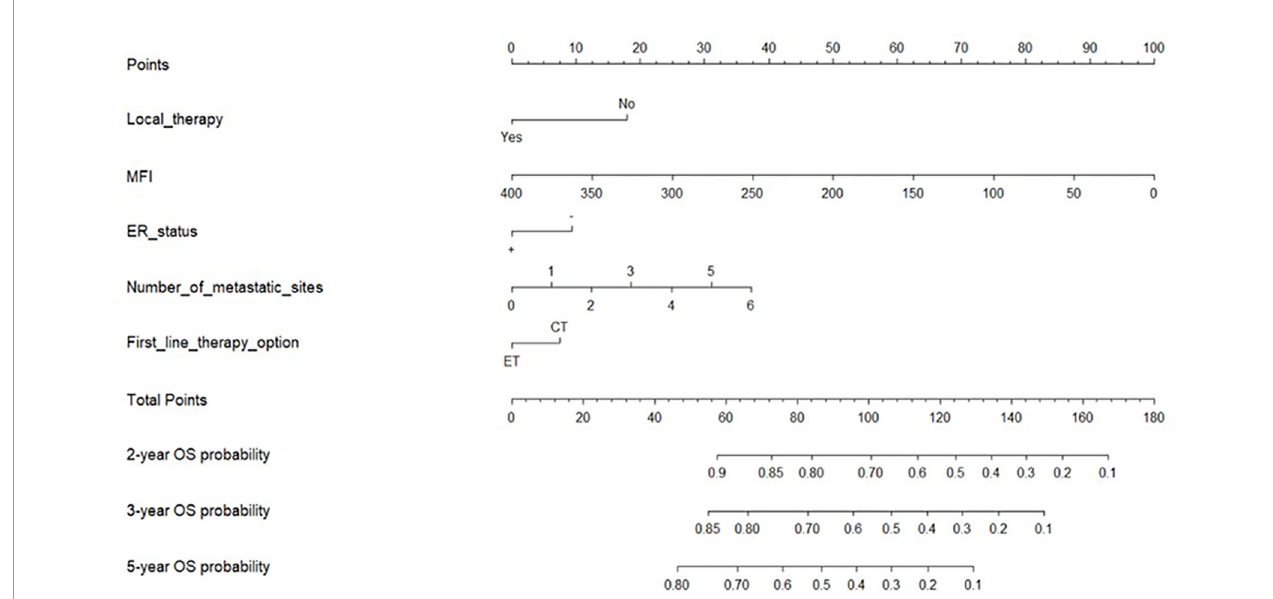
FIGURE 1 | Nomogram for predicting the 2-year, 3-year, and 5-year overall survival. Notes: Nomogram used when summing the points identi fi ed at top scale for each of the fi ve independent variables. This summed point score identi fi ed on total point scale was used to determinate 2-, 3- and 5-year overall survival (OS) probability of advanced breast cancer patients (ABC). MFI, metastatic-free interval; OS, overall survival; ER status, positive (+), negative (-); ET, Endocrine Therapy; CT,